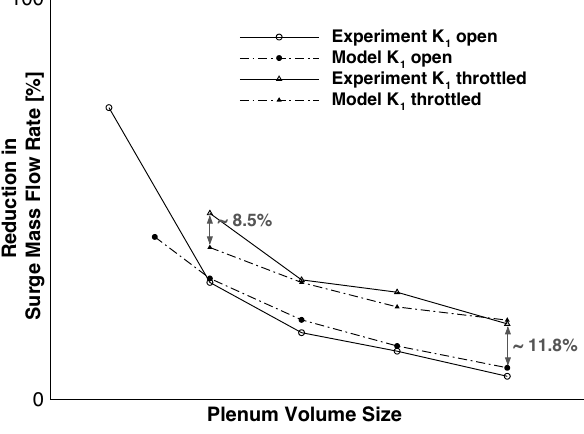
Figure 8. Shift in surge mass flow rate for plenum volume variation with inlet valve.